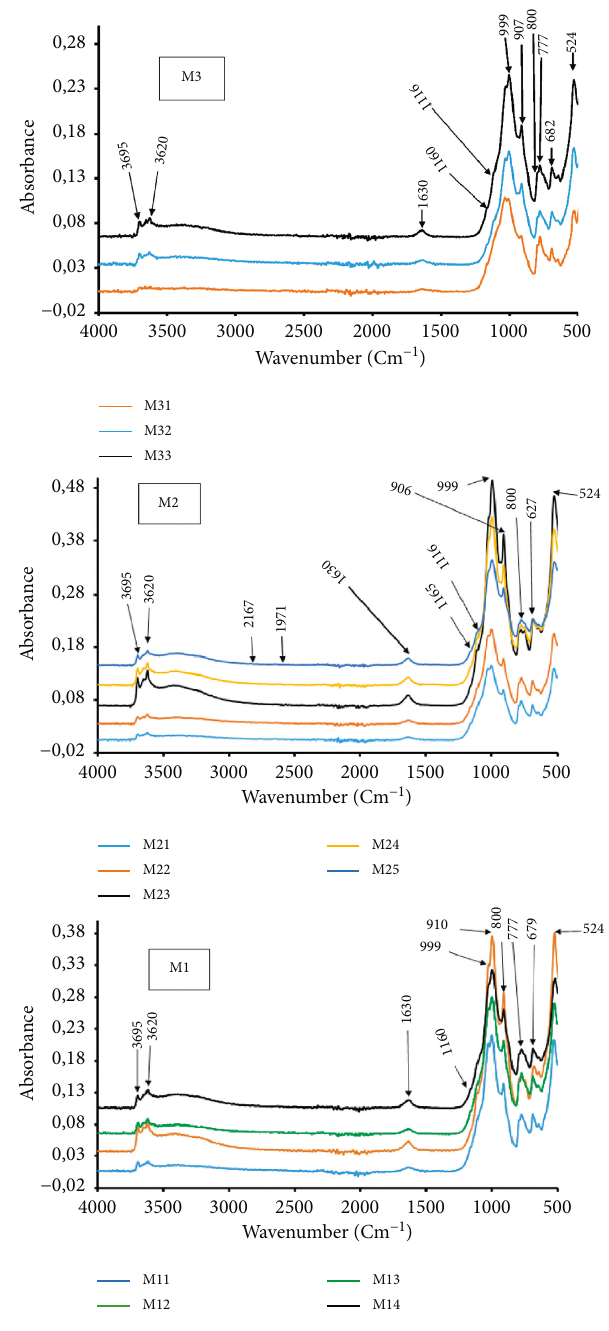
Figure 4: Infrared spectra of the studied clay fraction also reaches a high value of 198 cmol (+)/kg of clay but with a low value of 42.00 cmol (+)/kg of clay noted in the 11–80 cm depth.